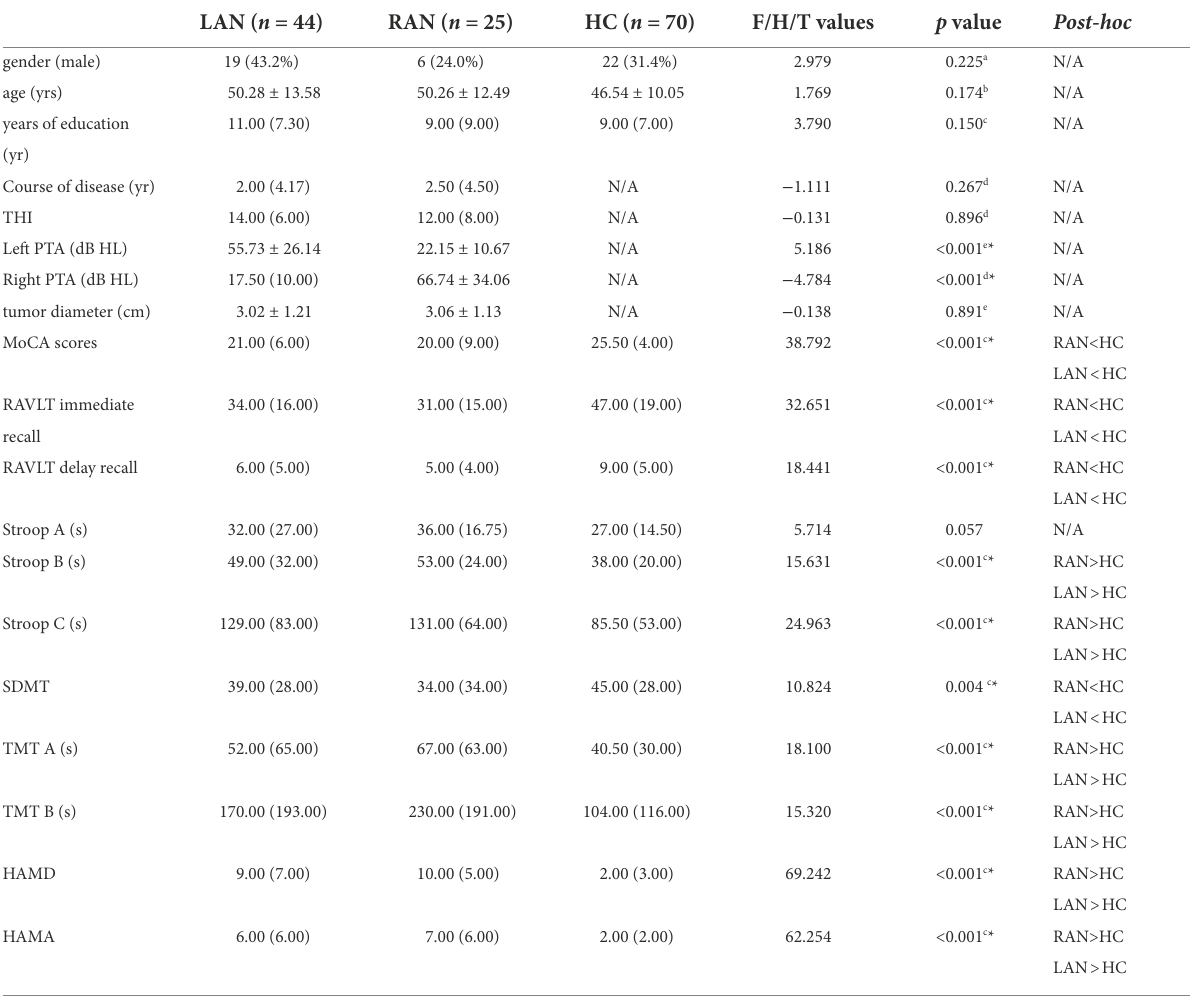
TABLE 1 Comparison of clinical data and cognitive function among LAN, RAN, and HC